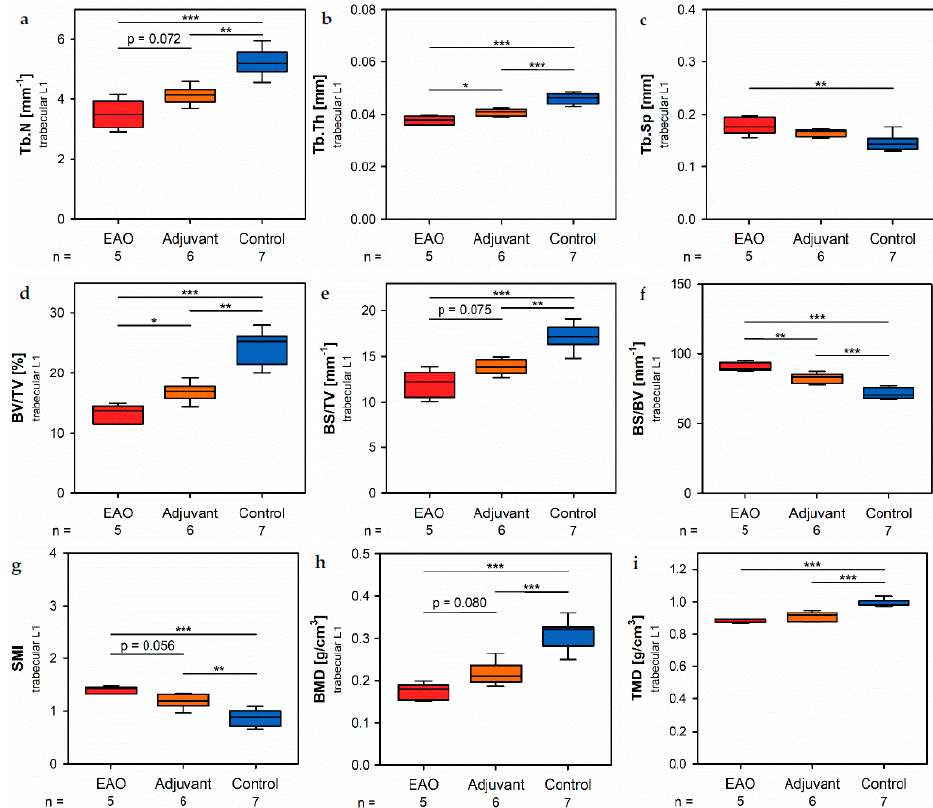
Figure 8. Microarchitecture of trabecular vertebral body L1 by µCT. Measurement of ( a ) trabecular number (Tb.N), ( b ) trabecular thickness (Tb.Th), ( c ) trabecular separation (Tb.Sp), ( d ) bone volume fraction (BV/TV), ( e ) bone surface density (BS/TV), ( f ) specific bone surface (BS/BV), ( g ) structure model index (SMI), ( h ) bone mineral density (BMD) and ( i ) tissue mineral density (TMD). Mice were immunized with testicular homogenate in adjuvant (EAO), adjuvant alone (adjuvant) or remained untreated (control). * p < 0.05; ** p < 0.01; *** p < 0.001.